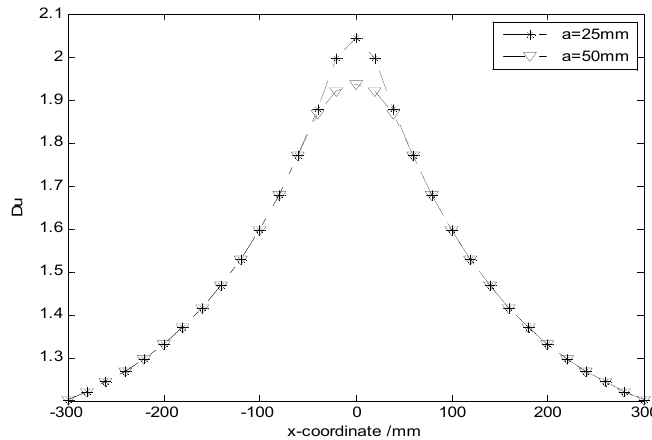
Figure 9. Variations of Du with x for different